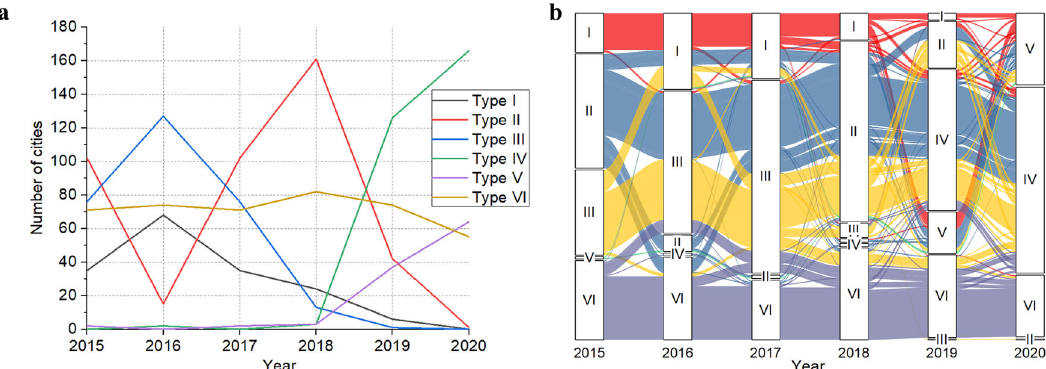
Fig. 6 Time evolution characteristics of the functional structure types of pseudo-human settlements (PHS). Subpanel a describes the annual changes in the number of cities represented by each functional structure type of PHS, and subpanel b describes the direction and extent of the circulation of each functional structure type of PHS with the year. The fi gure was developed by the authors using Origin Pro